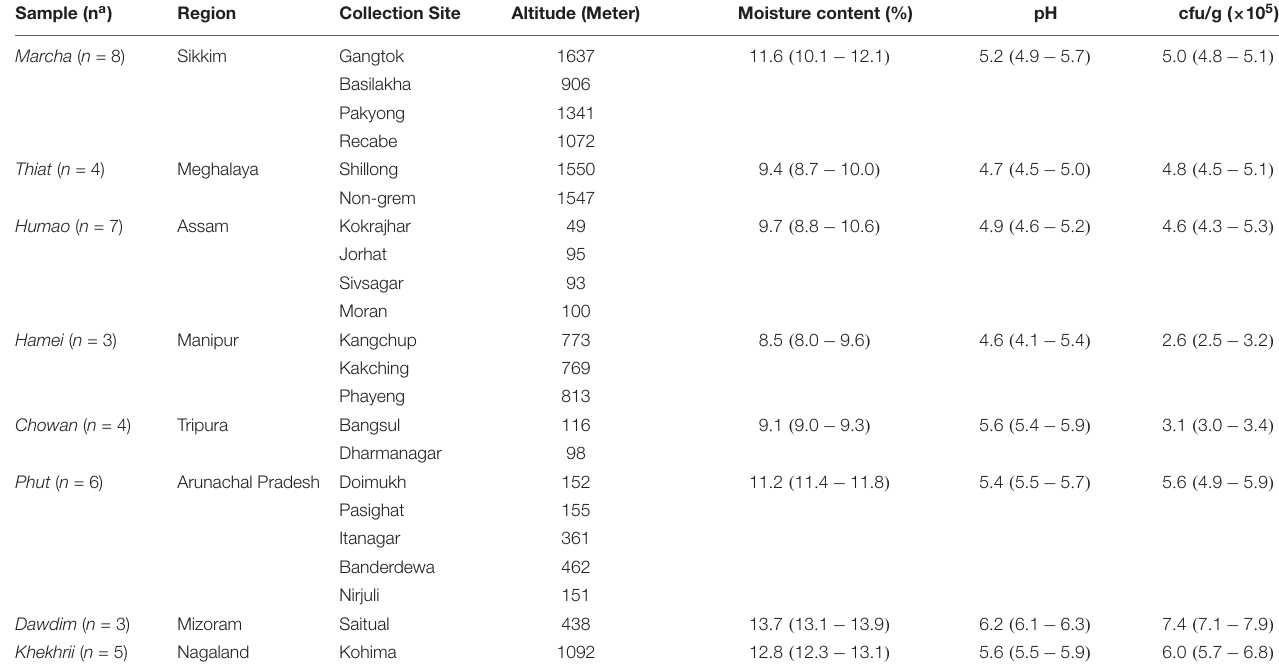
TABLE 1 | Geographical locations, pH, moisture content, and fungal populations of dry starters from North East India. Sample (n a ) Region Collection Site Altitude (Meter) Moisture content